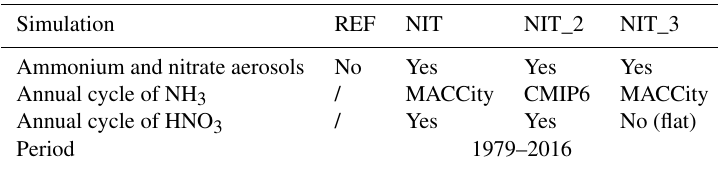
Table 3. Configuration of the different simulations in this study. Annual cycles of NH 3 and HNO 3 of the different simulations are presented in Figs. 2 and